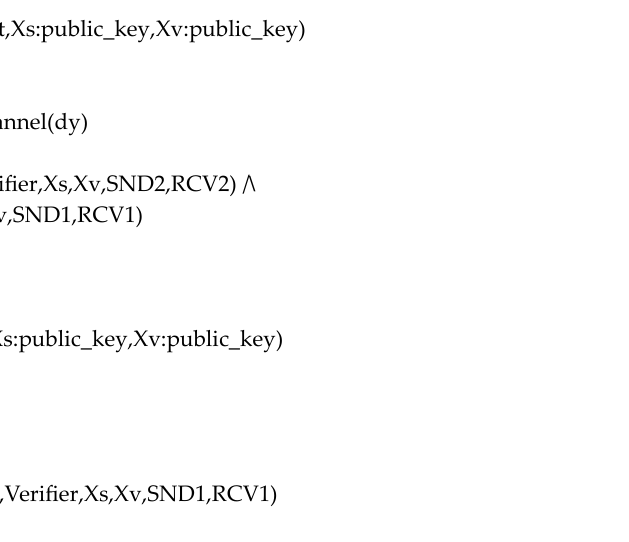
Algorithm A3 High-level protocol specification language (HLPSL) code for Sessions role role